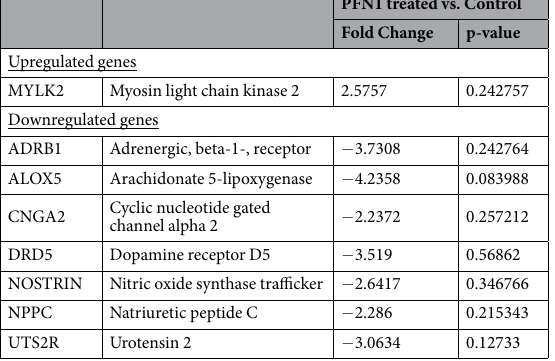
Table 1. Genes altered by PFN1 ( > 2-fold) in decidualized (treated with E + MPA for 10–12 days) HESC stimulated with 100 µ M PFN1 for 6